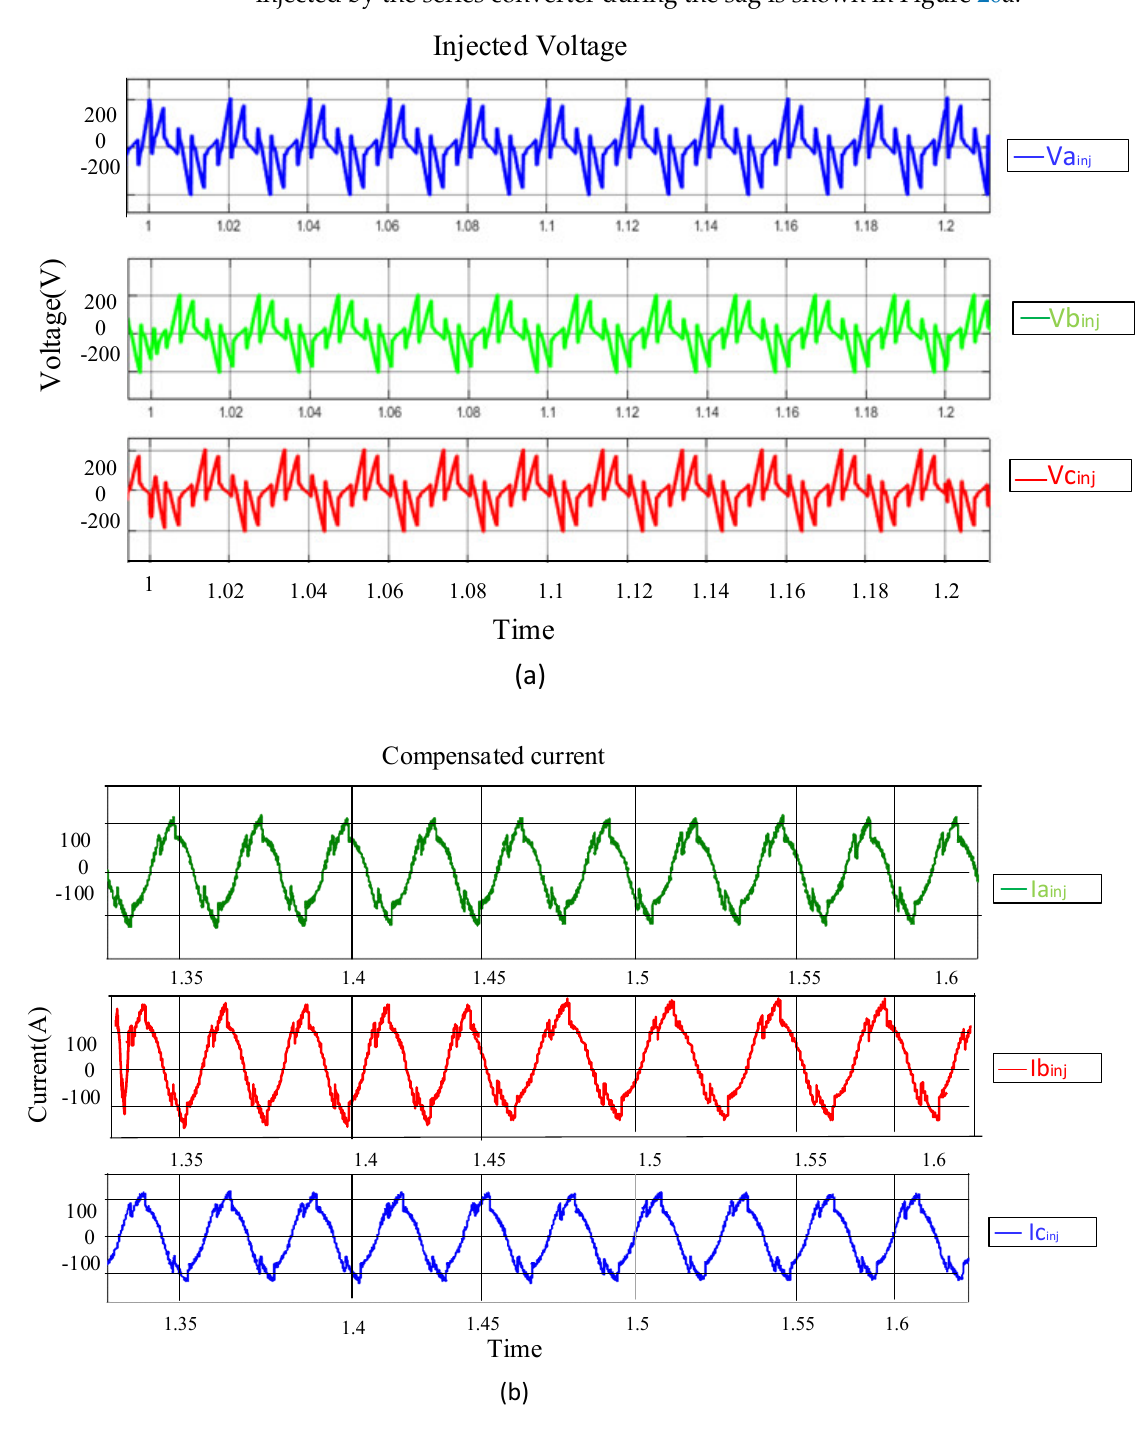
Figure 20. ( a ) Injected voltage ( b ) Compensated current.